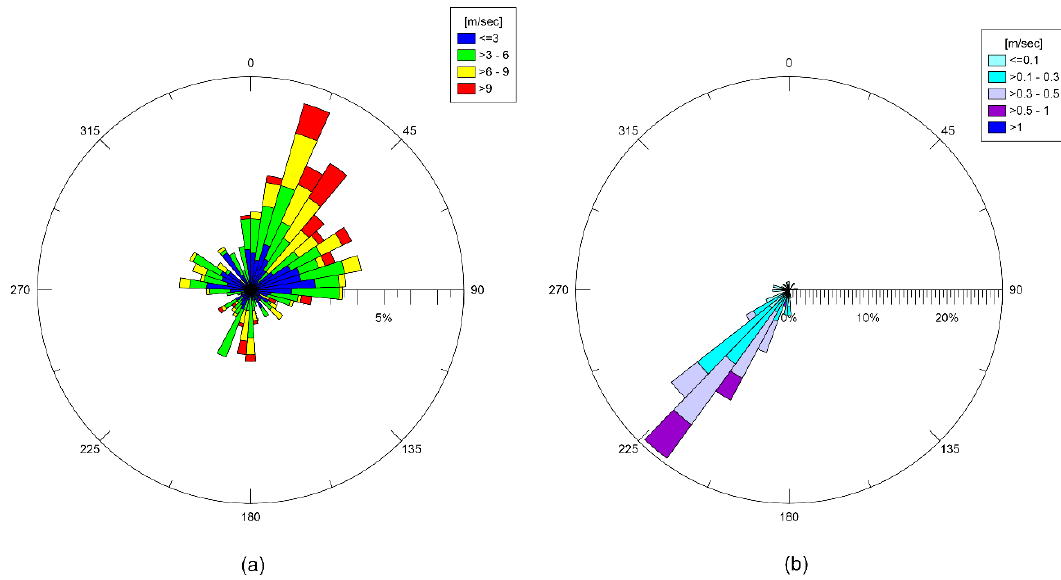
Figure 4. Polar plot of measured ( a ) wind and ( b ) waves in March 2020.